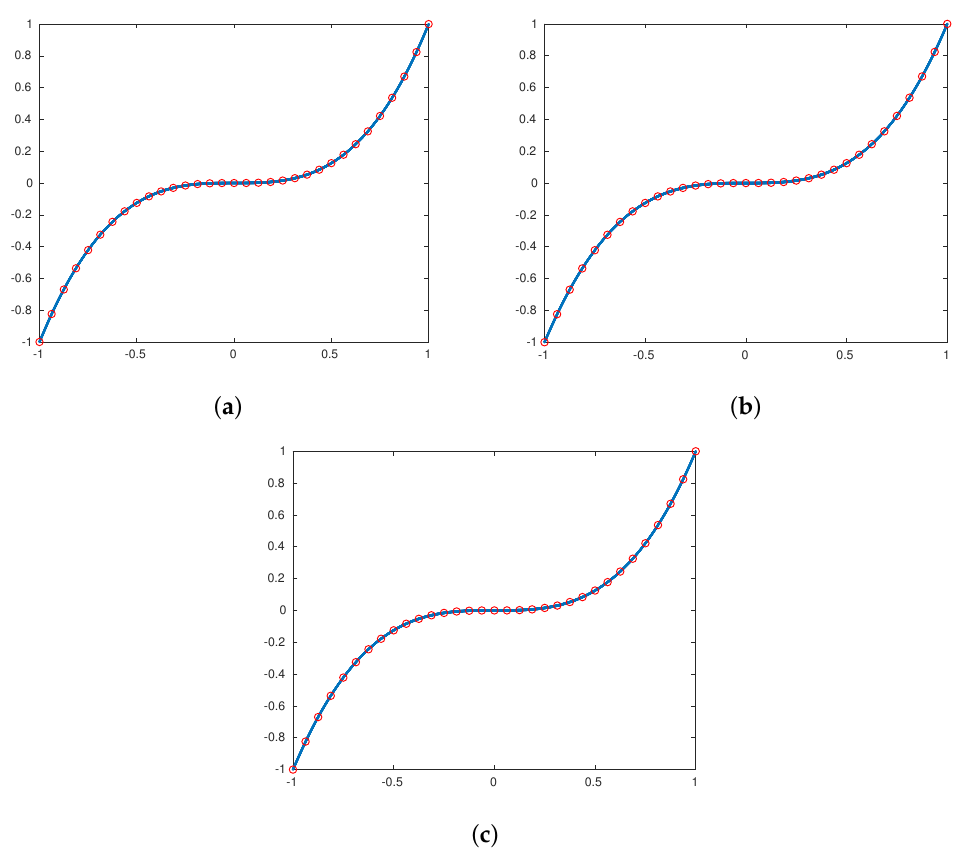
Figure 9. The limit functions in 1d using five subdivision scales; the results shown in ( a – c ) were obtained by S 4 (15) with w = − 5 , S 5 (17) with w = − 2 and S 6 (19) with w = − 7 3 figure, the original sampling is represented in ◦